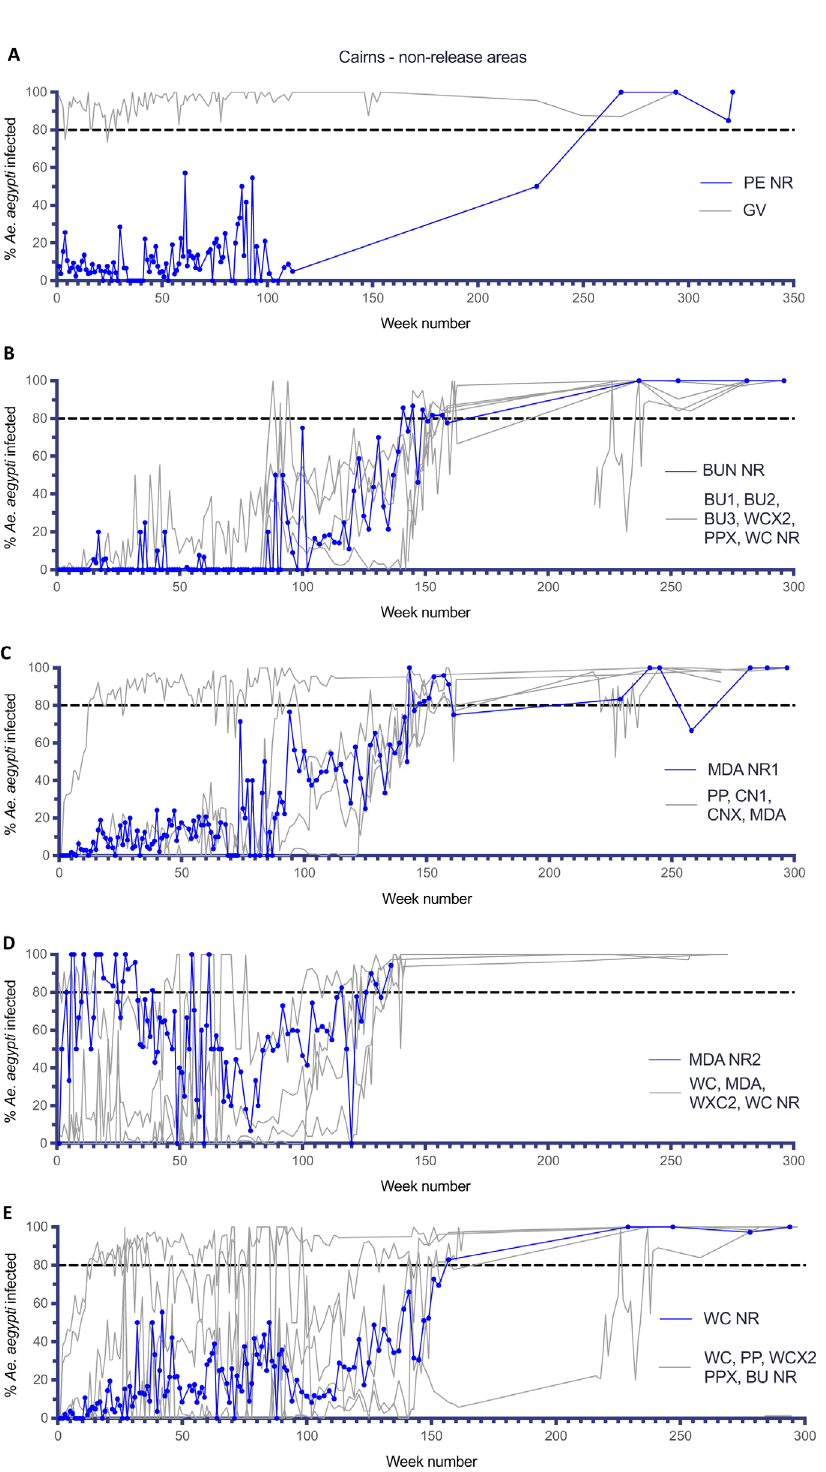
Figure 15. Wolbachia infection rates in Aedes aegypti mosquitoes collected from Pyramid Estate non-release area (PE NR) ( A ), Bungalow non-release area (BUN NR) ( B ), Manunda non-release area 1 (MDA NR1) ( C ), Manunda non-release area 2 (MDA NR2) ( D ) and Westcourt non-release area (WC NR) ( E ) non-releases areas. Week number 1 corresponds to commencement of Wolbachia mosquito monitoring in each non-release area (PE NR week 1 = 21/12/2012, BUN NR week 1 = 11/01/2013, MDA NR1 week 1 = 11/1/2013, MDA NR2 week 1 = 07/06/2013, WC NR week 1 = 11/01/2013). Grey lines show corresponding weekly Wolbachia infection rates in Aedes aegypti mosquitoes collected from adjacent release or non-release areas (areas described in Figure 2 and Table 1).